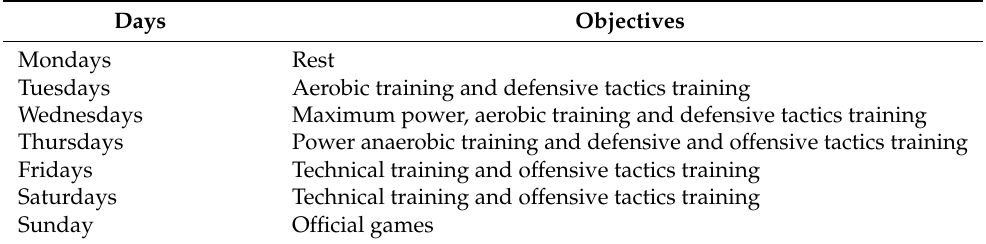
Table 1. Details of general training routine during the week undertaken by both control and experi- mental groups over the 8-week